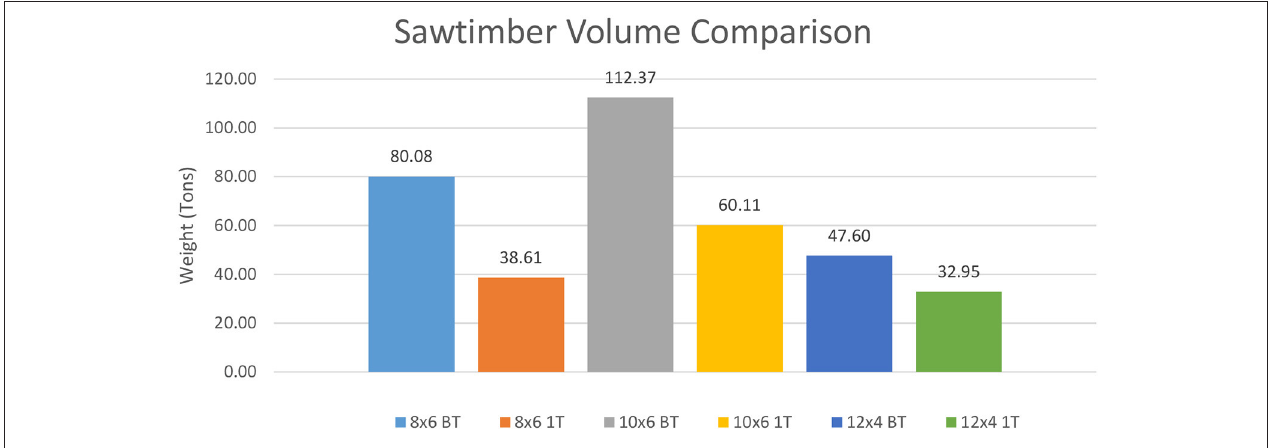
FIGURE 4 | Sawtimber Volume Comparison for all Ptaeda